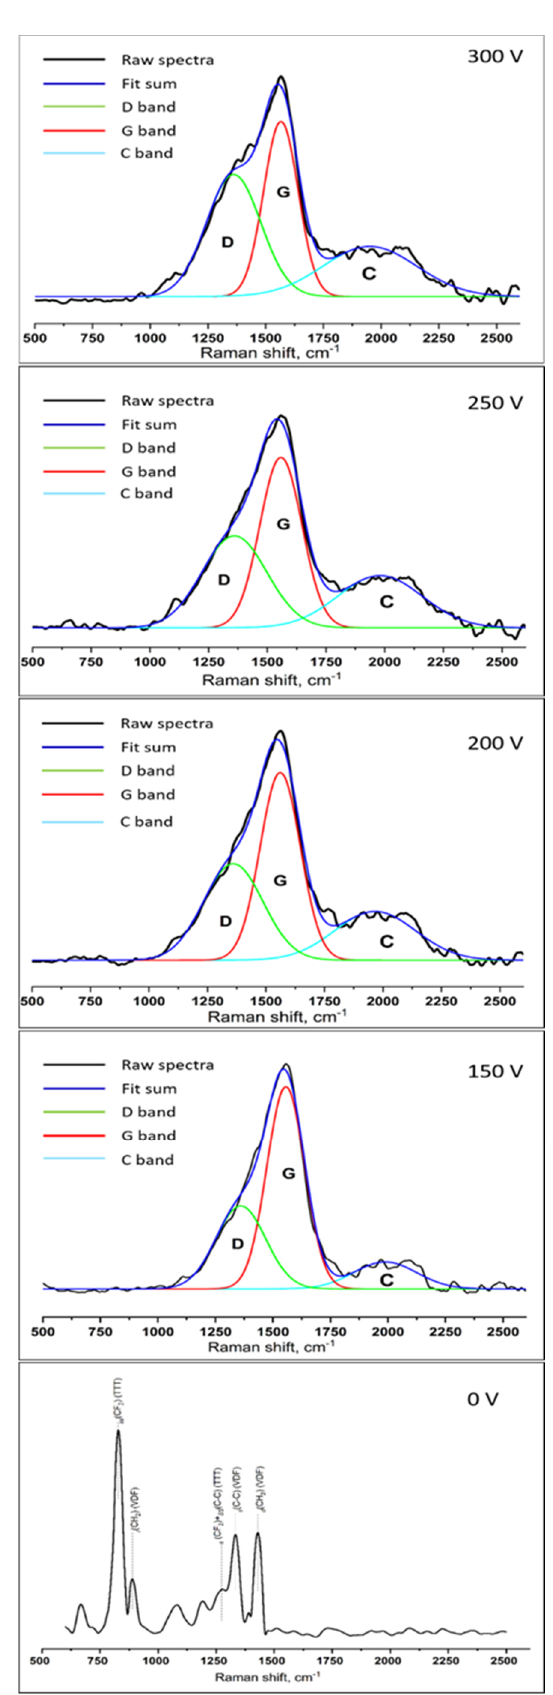
Figure 4. Raman spectra of the obtained membranes.